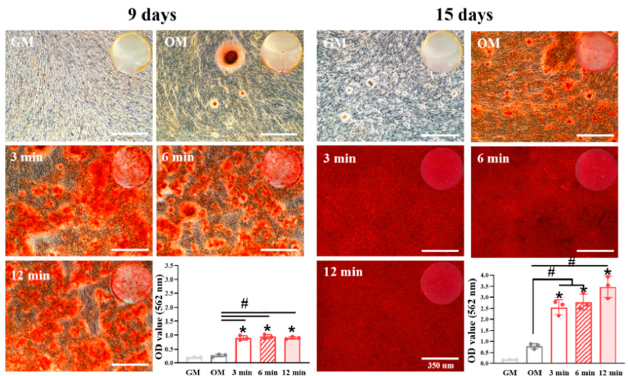
Figure 4. In vitro odontogenic di ff erentiation by alizarin red S staining after 9 and 15 days of SHED exposure to tricalcium silicate nanoparticle-containing cement (Biodentine ™ ) extracts. The mineral nodules formed remarkably in all the odontogenic media formulated with the 12.5% extraction group (3, 6 and 12 min) compared those in the growth medium, odontogenic medium, and after setting group at day 9. At day 15, the di ff erence in mineralization in the odontogenic medium and extraction groups was observed more clearly. Optical images scanned by a photo scanner were added into the phase contrast images observed by microscope and quantification performed at 562 nm by a microplate reader. # indicates a significant di ff erence between the odontogenic medium and experimental groups, and the asterisk indicates a significant di ff erence between the growth medium and experimental groups ( p < 0.05); All scale bars represent 350 µ